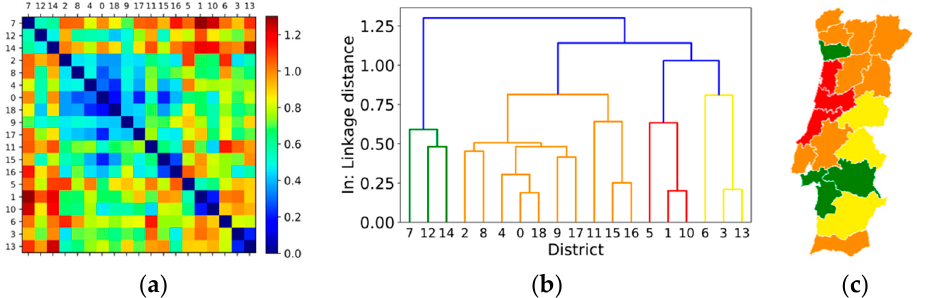
Figure 12. Deliberate causes (In): ( a ) Dissimilarity matrix; ( b ) Clusters by relative annual profile of distribution; ( c ) Clusters in geographic location (cophenetic coefficient: 0.72).